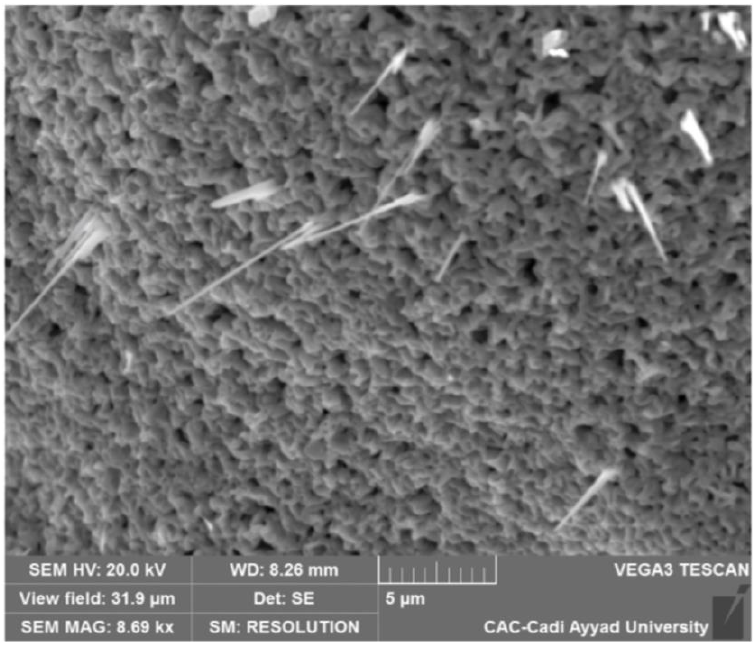
Figure 1. Scanning electron microscopy (SEM) image of CuO nanowires synthesized by thermal oxidation of copper foil at 550 °C for 4 h with a heating rate of 15 °C/min. The image shows the fragility and destruction of the nanowires at a relatively high heating rate [51].